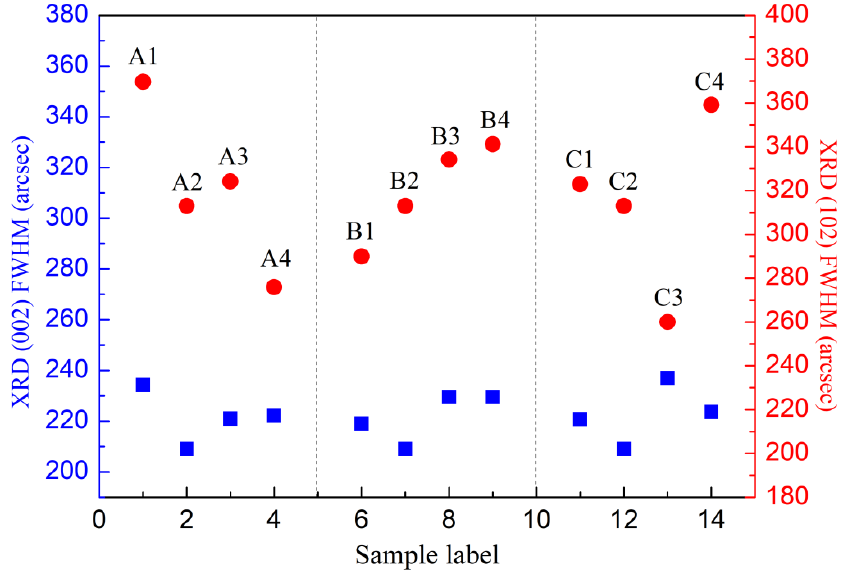
Figure 8. The full width at half maximum of (002) plane and (102) plane of three groups of samples.